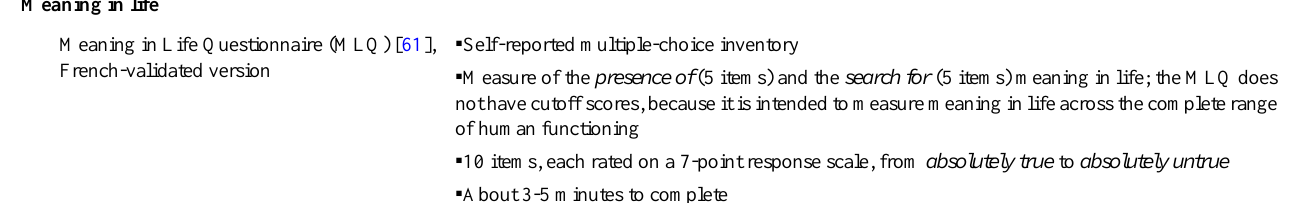
Main characteristics of the instrumentVariable and